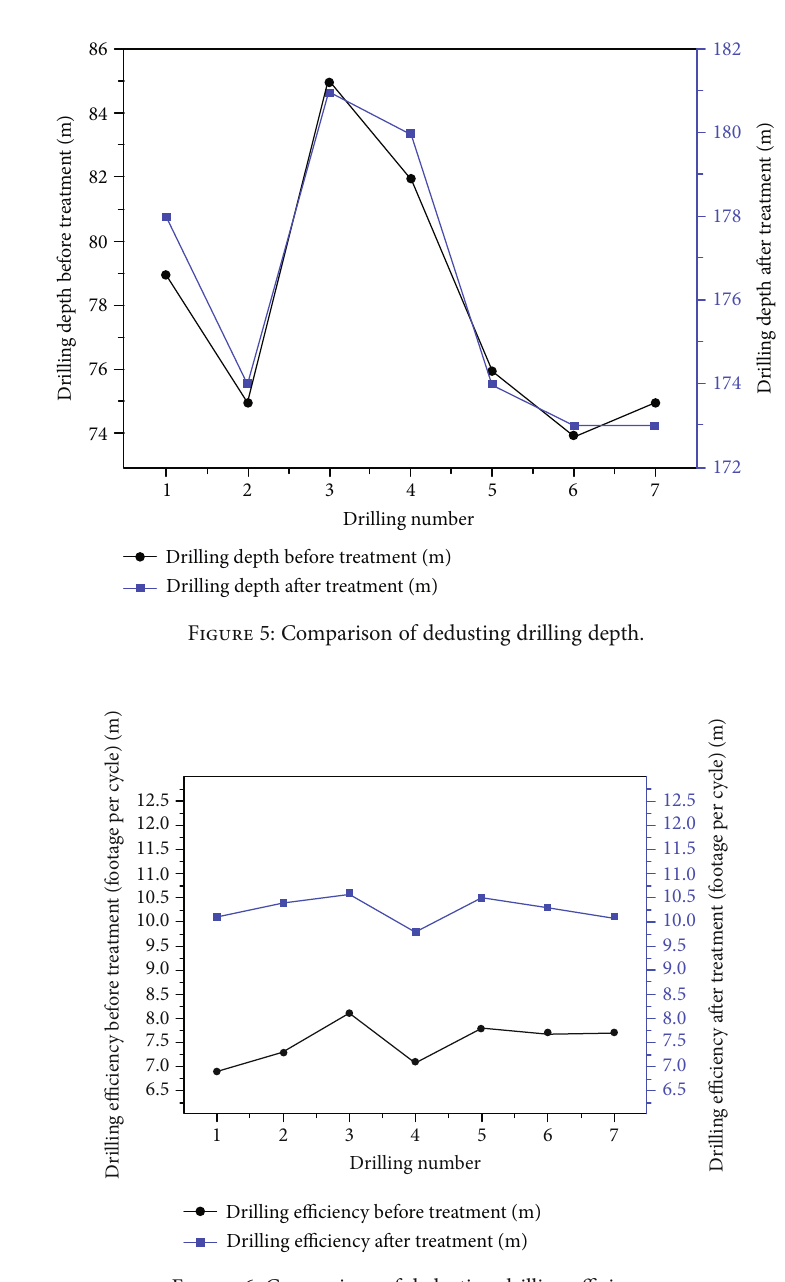
Figure 6: Comparison of dedusting drilling e ffi